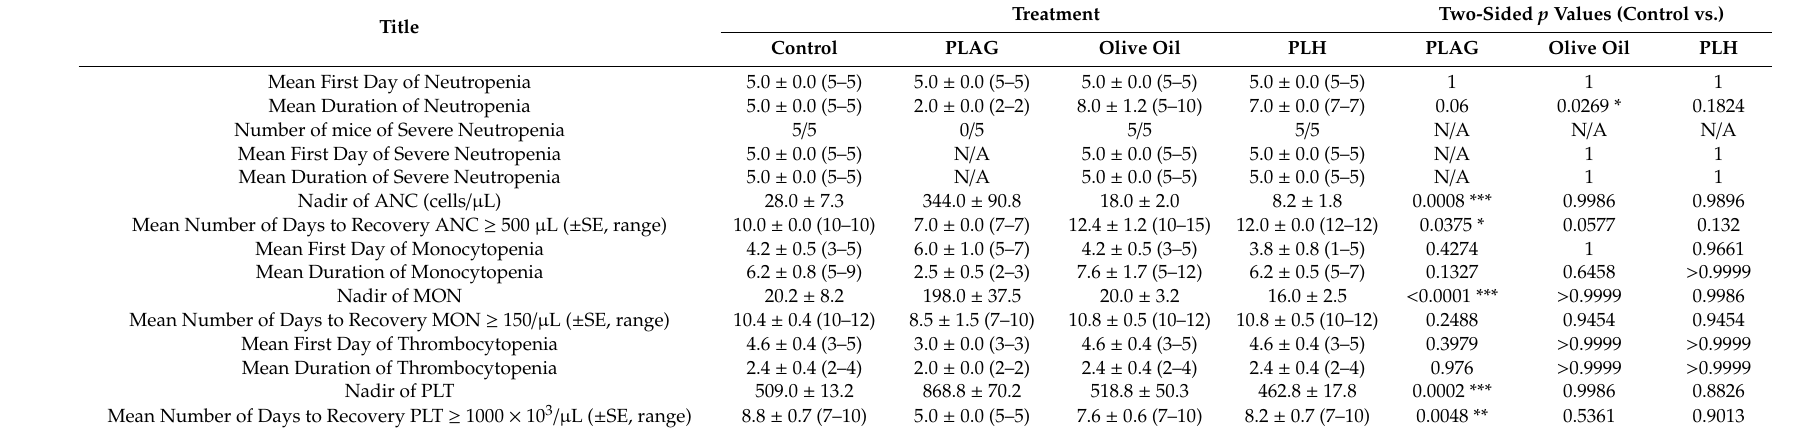
Table 4. E ff ect of PLAG, olive oil, and palmitic linoleic hydroxyl glycerol (PLH) administration in 5-FU-induced hematological